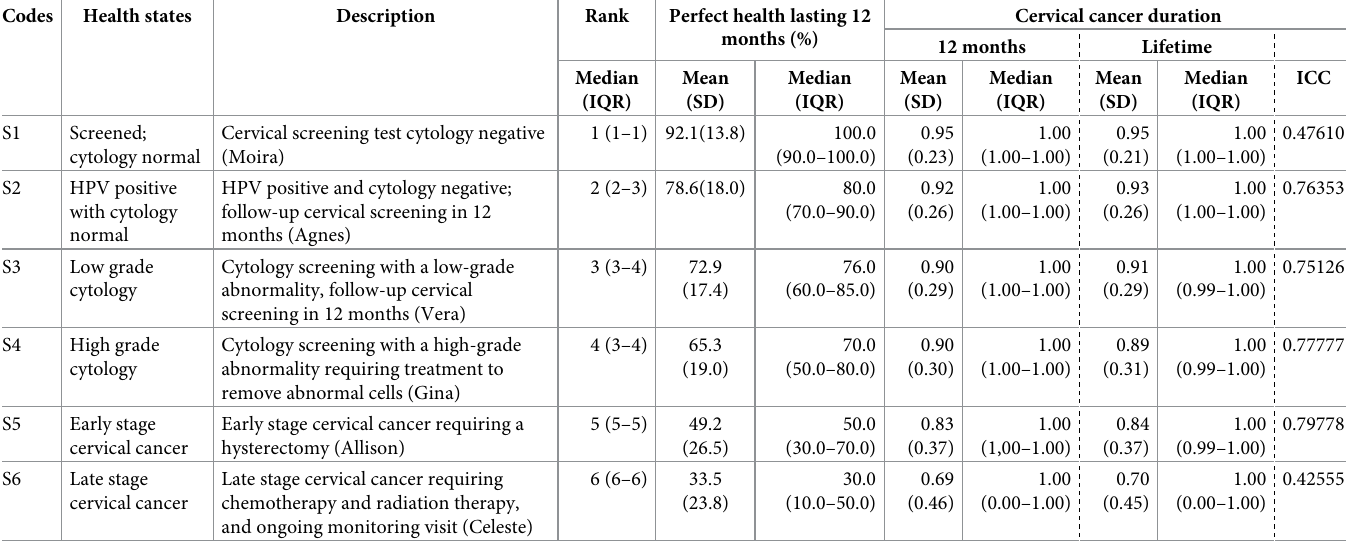
Table 2. Hypothetical health state scenarios relating to genital HPV infection and cervical cancer, ranks and percentages of perfect health by six health states lasting 12 months, standard gamble utility scores and intra-class correlation coefficient for cervical cancer duration among Indigenous women. Codes